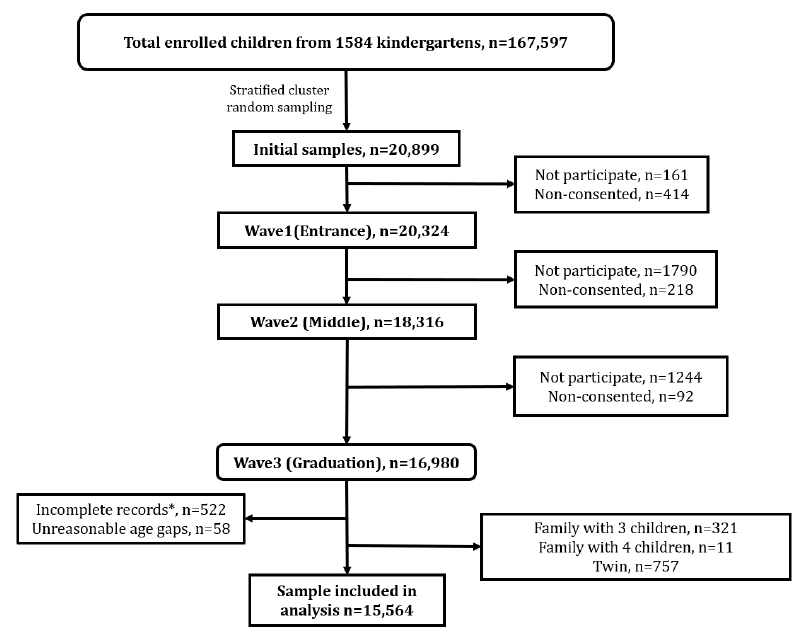
Figure 1. Flow chart of included analytical sample. * In any of the three waves, missing data on variables including SDQ, eHCI, age, sex, Hukou (the location of registered residency of the child), district, kindergarten classification, and CPCIS was considered as incomplete record. Table 1. Descriptive statistics of overall sample and each group in Entrance wave.